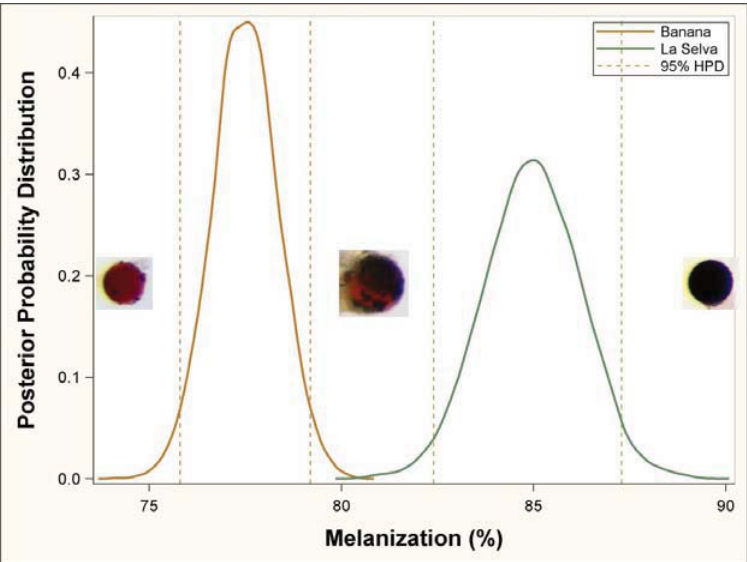
Figure 2. Posterior probability distribution of the melanization response for caterpillars feeding on banana leaves (pesticide) and La Selva leaves (pesticide-free). Dotted vertical lines reference the 95% highest probability density (HPD) interval. Non-overlapping HPD intervals for the two distributions indicate that the mean melanization for each population is different. Sample bead images across the distributions are representative of low, medium, and high levels of melanization.